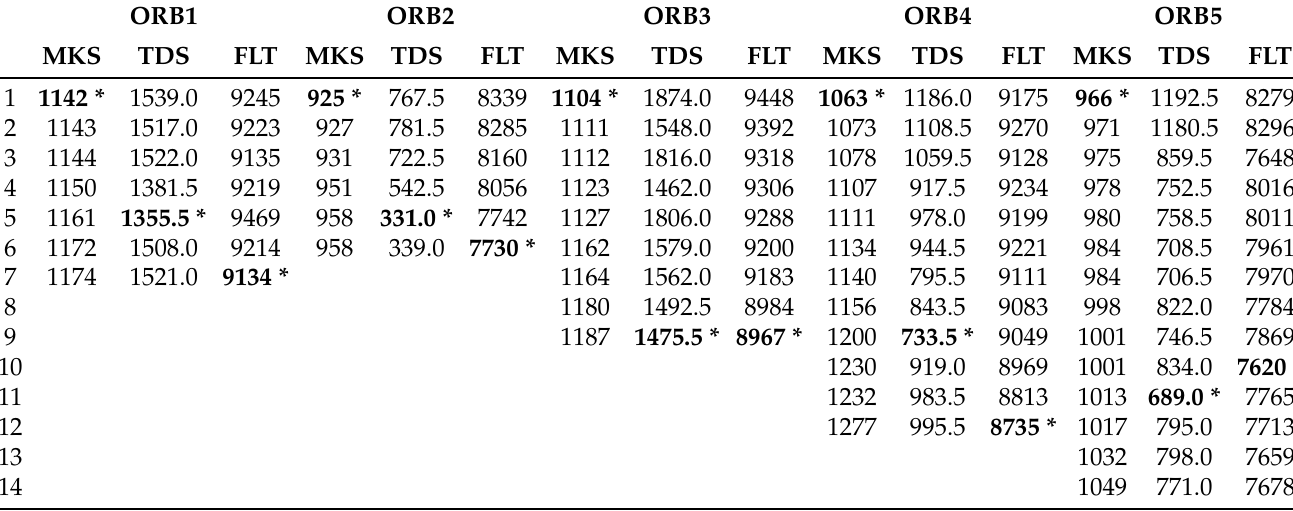
Table A2. Non-dominated front obtained by CMOSA for the JSSP instances proposed by